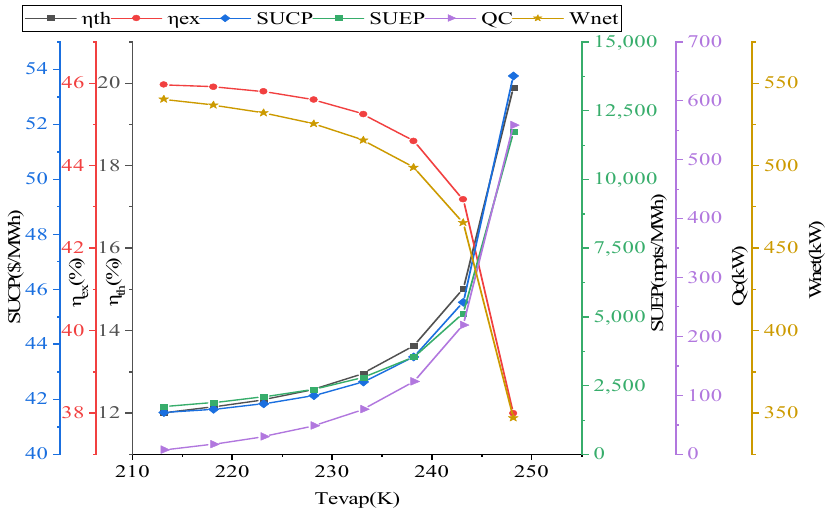
Figure 7. Effect of evaporation temperature on system performance.